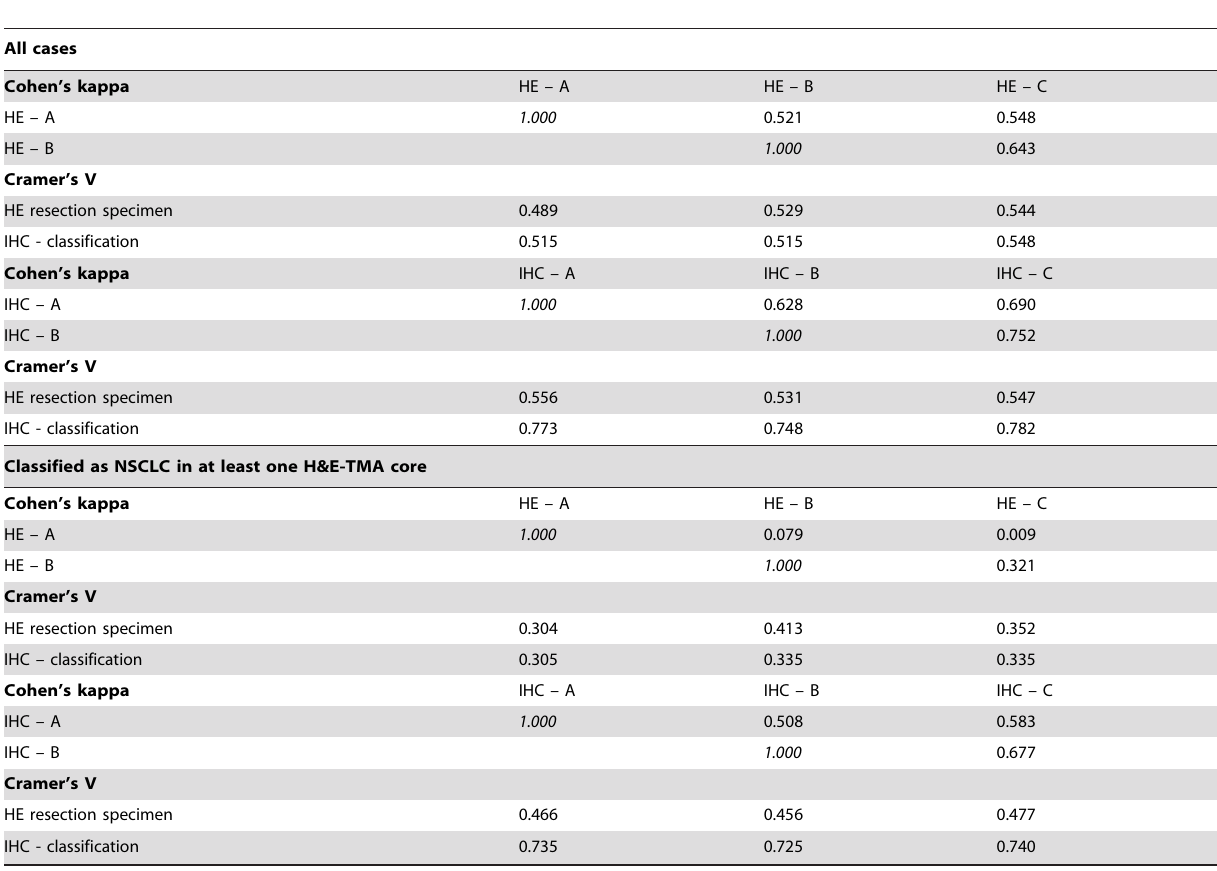
Table 2. Inter-core agreement for H&E diagnosis and additional IHC classification